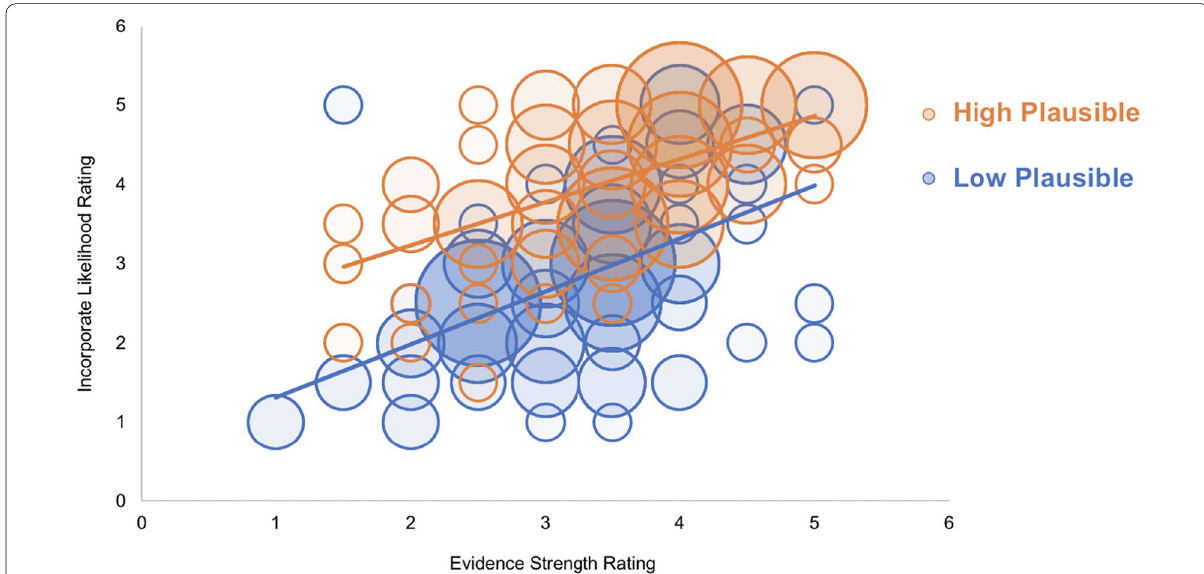
Fig. 6 Correlations between evidence strength and incorporate likelihood ratings as a function of intervention plausibility ( high plausible low plausible blue) for Experiment 2. Size of bubbles reflects the number of participants for each data =